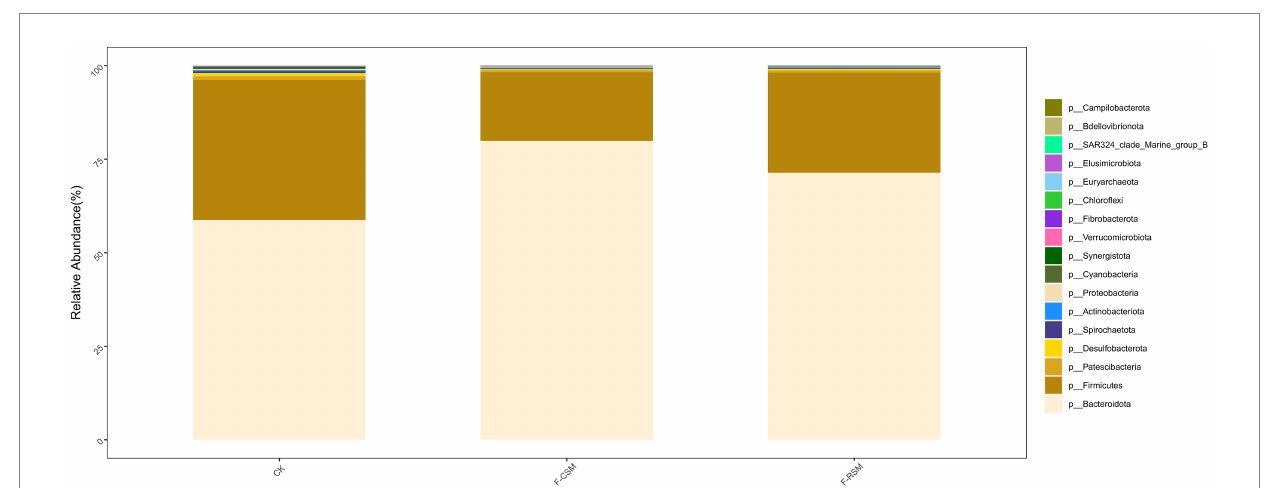
FIGURE 3 Effects of the diets on compositional profifiles of rumen microbiota of Hu sheep (Phylum level; %). CK, non-fermented group; F-CSM, fermented cotton seed meal TMR; F-RSM, fermented rapeseed meal